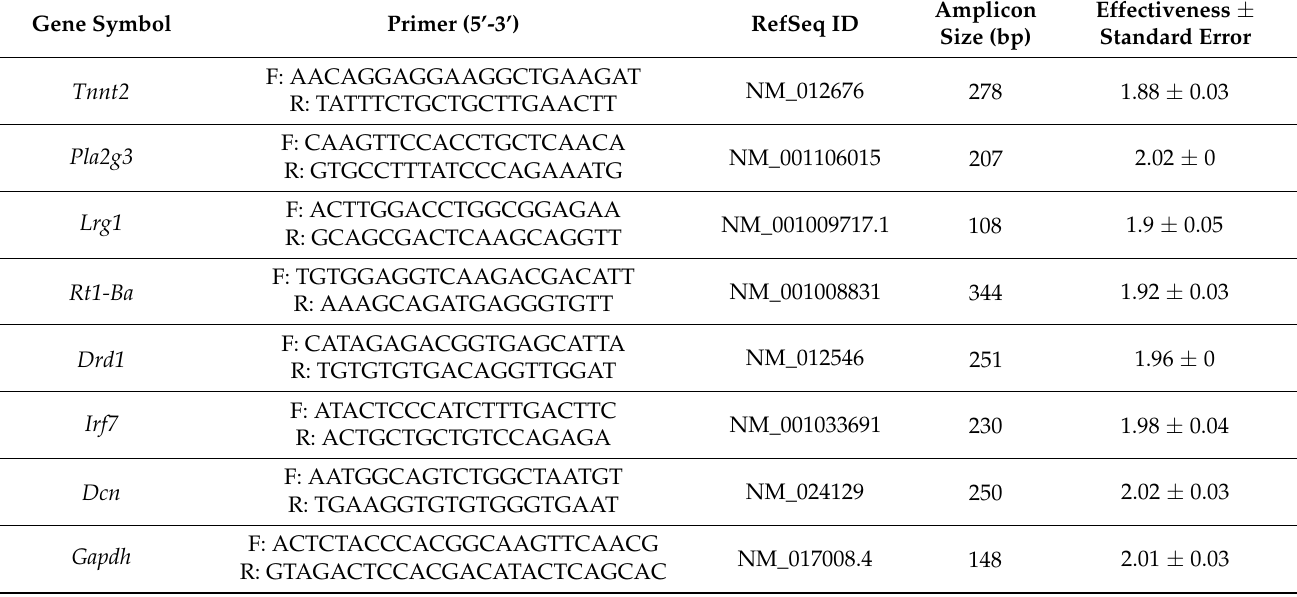
Table 1. The characterization of the primers for real-time